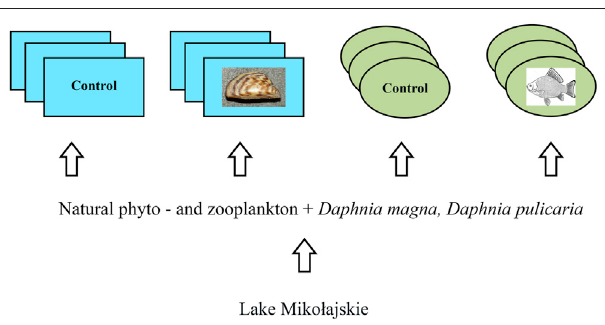
FIGURE 1 | Experimental setup. Each blue rectangle (2017-experiment with zebra mussels) or green oval (2018-experiment with fi sh) represents